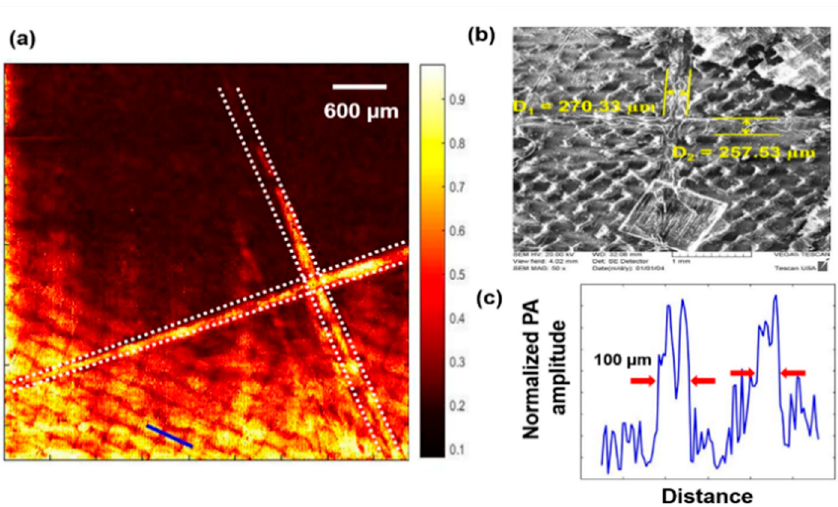
Figure 3. X-Y plane image. ( a ) pNDE X-Y plane image; the ‘X’ marking is highlighted. ( b ) SEM image; the width of the ‘X’ marking is calculated. ( c ) Full width at half maximum (FWHM) measurements along the blue line on the pNDE image, which are taken as the lateral resolution of the image.